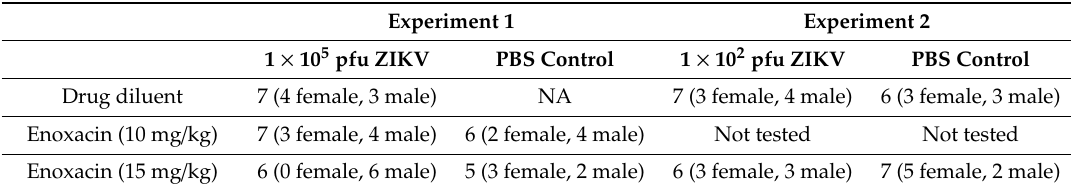
Table 2. Number of ZIKV-infected and control mice treated with enoxacin or drug